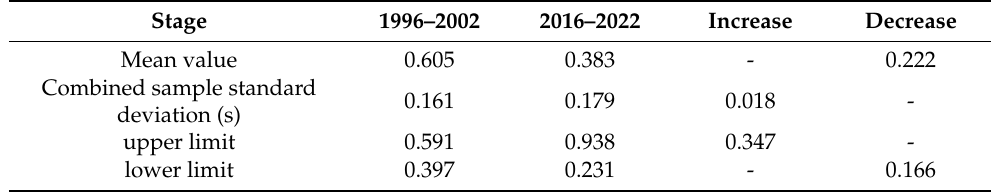
Figure 1. Statistical of pathological score of type I reference product in 2016 – 2022. N = 19 times. Table 1. Statistics for two stage of type I. Table 1. Statistics for two stage of type I.